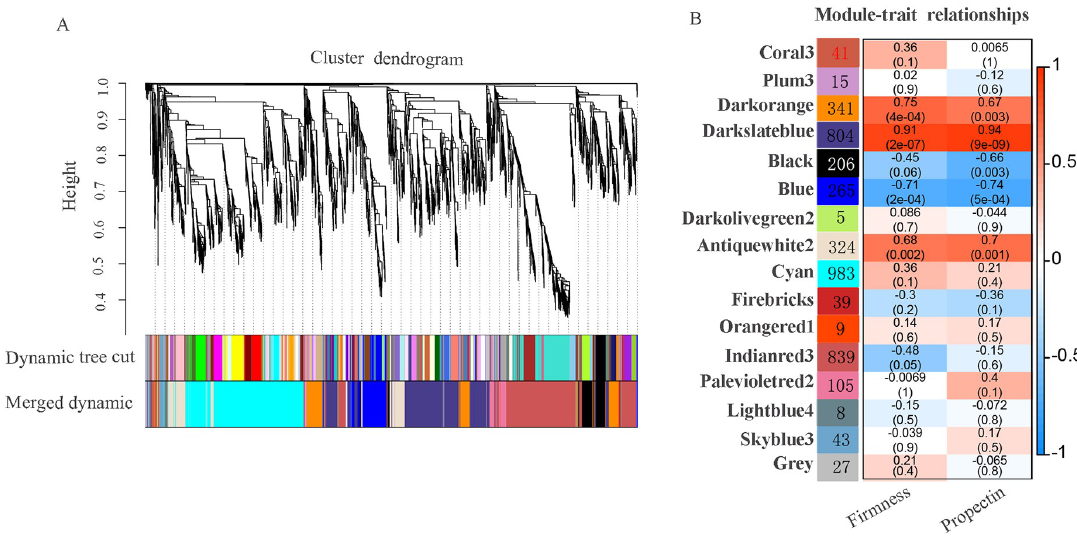
Fig 6. Coexpression network analysis of DEGs between ‘Red Globe’ and ‘Muscat Hamburg’ at three developmental stages. (A) Hierarchical cluster tree showing 16 modules of coexpressed genes. Each of the 4,559 DEGs is represented by a leaf in the tree, and each of the sixteen modules is represented by a major tree branch. (B) Heatmap of correlations and corresponding p-values for 16 gene modules. The left panel shows 16 modules and the number of genes in each module. The upper number shows the correlation from − 1 to 1, and the lower number shows the p-value in the right